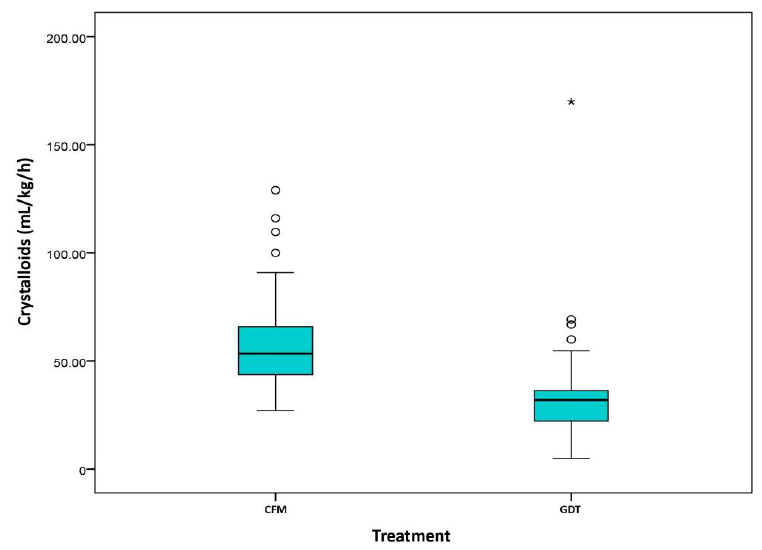
Figure 3. Crystalloids (mL/kg/h) (Day 1). Classical fluid management (CMF)/Goal directed therapy (GDT).